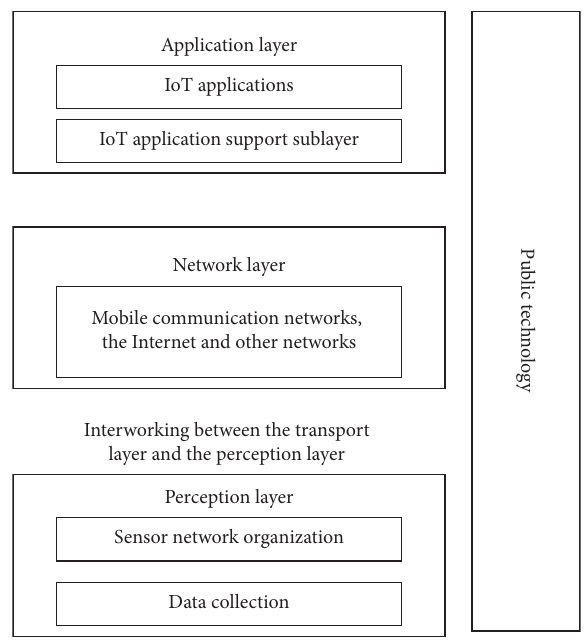
Figure 1: Technical system framework of the Internet of